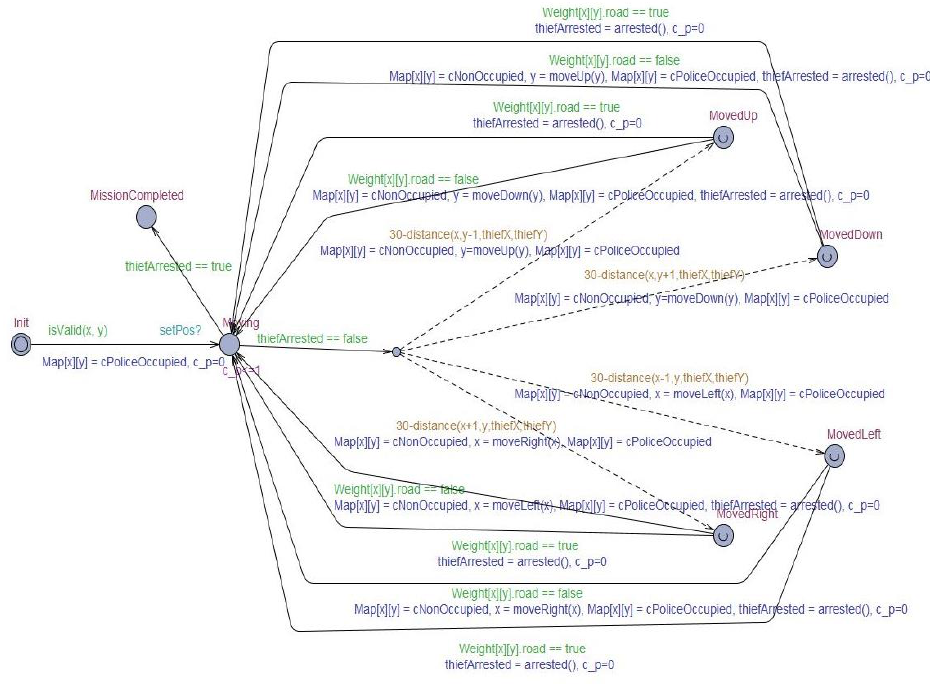
Table 2. Probability of arresting a criminal suspect according to the increase of unmanned patrol cars.